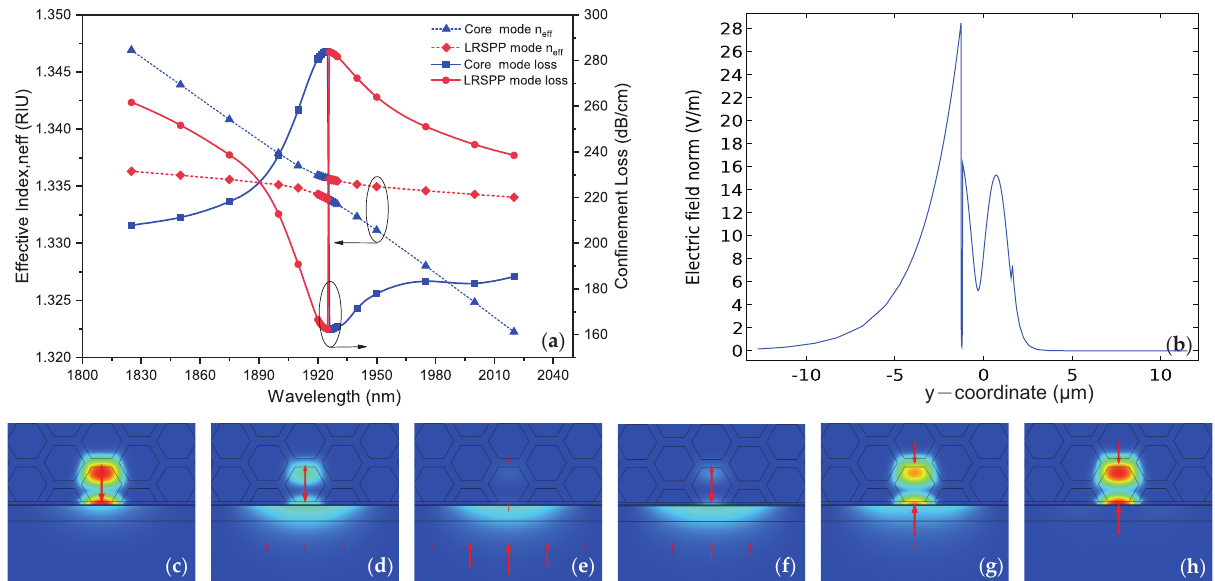
Figure 2. ( a ) Dispersion relationship (solid lines) and attenuation spectra (dot lines) of the core mode (blue), LRSPP mode (red). ( b ) The electric field profile along y axis of the LRSPP mode at 1900 nm. ( c – e ) and ( f – h ) are the electric field distributions of the core mode and LRSPP mode at the wavelength of 1900 nm, 1925 nm and 1950 nm, respectively. They illustrate the mode conversion around the avoided-crossing region. The red arrows in ( c – h ) denote the directions of electric